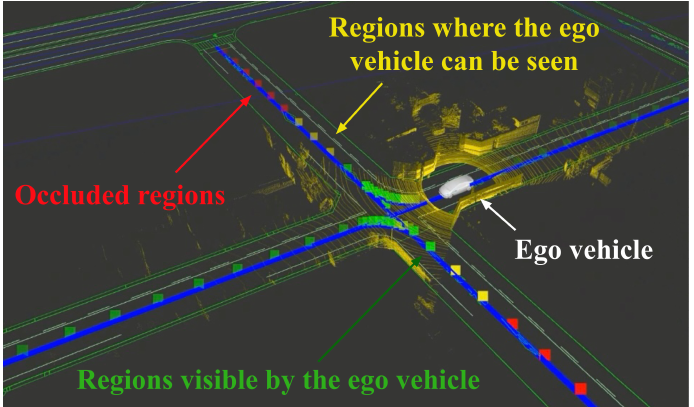
Figure 4. An example of a visibility estimation result using real sensing data used in our previous work [11]. The green, yellow, and red squares indicate the regions observable by the ego vehicle, the regions where other vehicles can observe the ego vehicle, and the occluded regions, respectively. The visibility estimation approach in our previous work can be directly incorporated into the planner proposed in this paper for applications in complex real-world